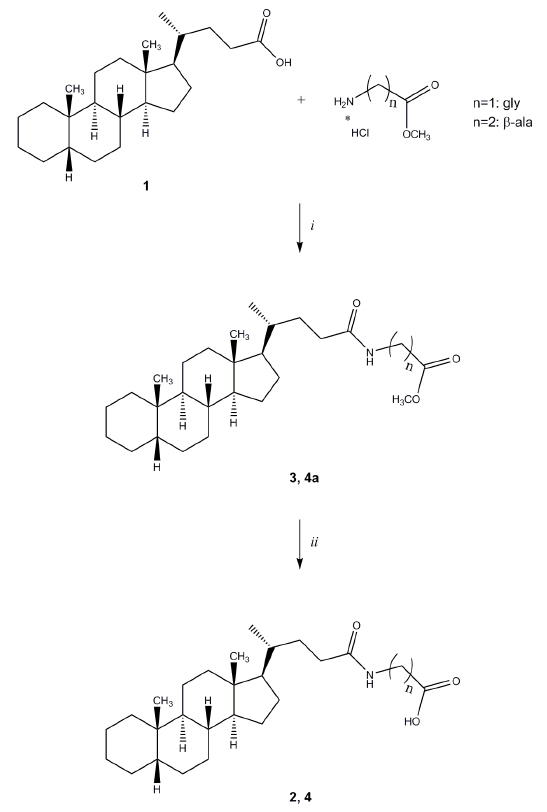
Scheme 1. General synthesis of compound 2 and 4 . a